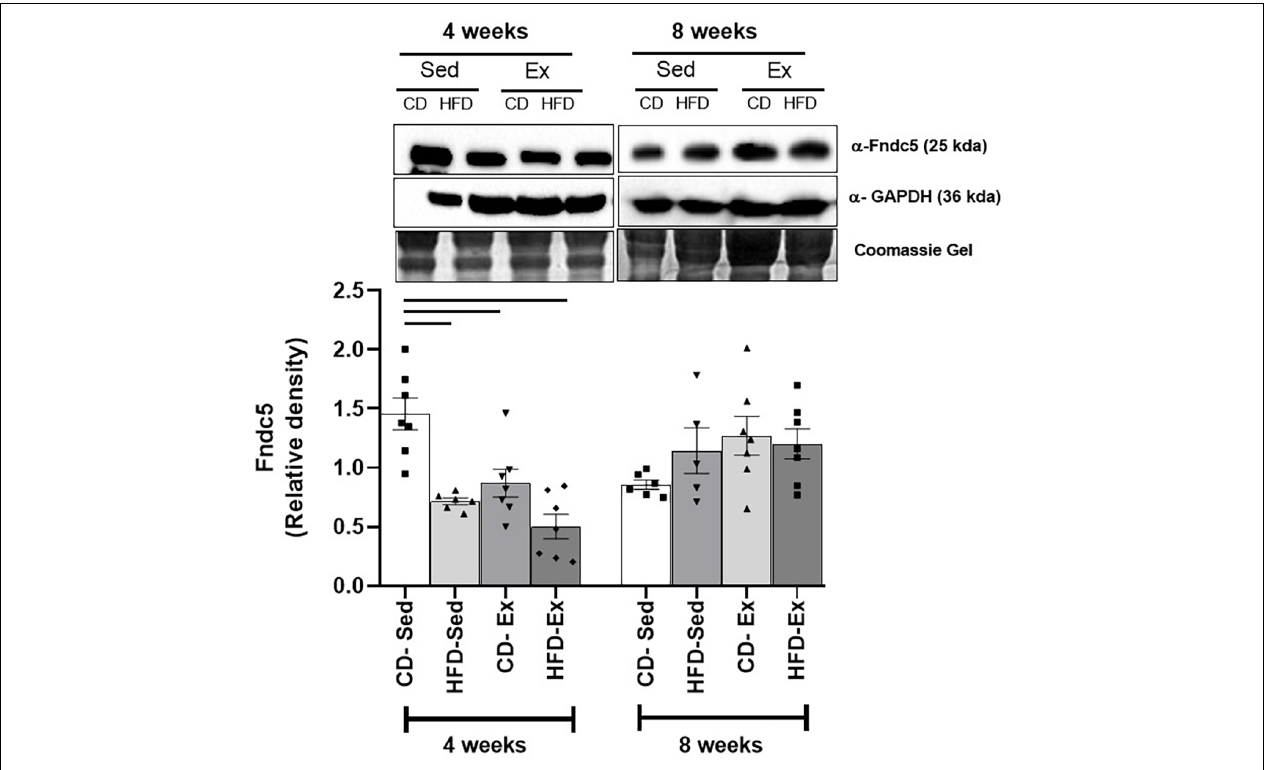
FIGURE 7 | Protein expression of FNDC5. The presence of a 25 kDa band was detected in the gastrocnemius with anti-FNDC5 antibodies after 4 and 8 weeks of dietary intervention and training; GAPDH was used as a loading control. HFD-Ex: high-fat diet and exercise; HFD-Sed: sedentary high-fat diet; CD-Ex: chow diet and exercise; CD-Sed: sedentary chow diet. The bars represent the significant differences between the indicated groups. The results are presented as means ± SEM ( p <